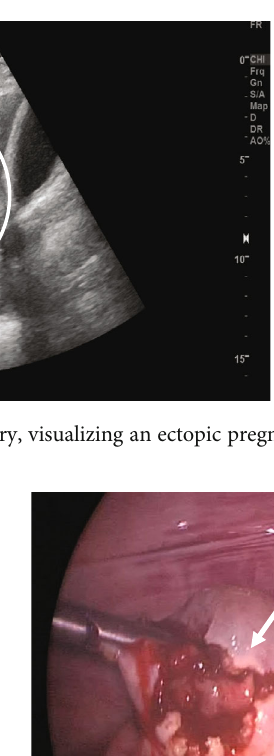
Figure 1: Pelvic sonography showing an empty uterus with thin endometrium (A) and free fl uid (B).